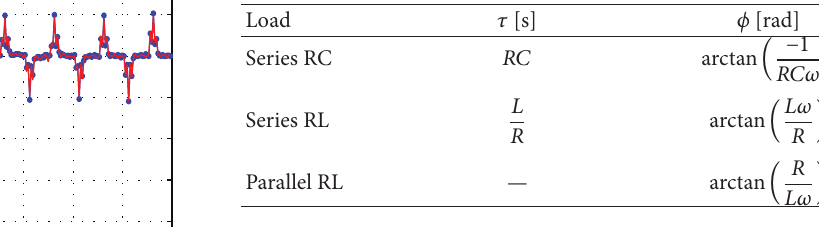
Table 6: Dependent parameters of first-order